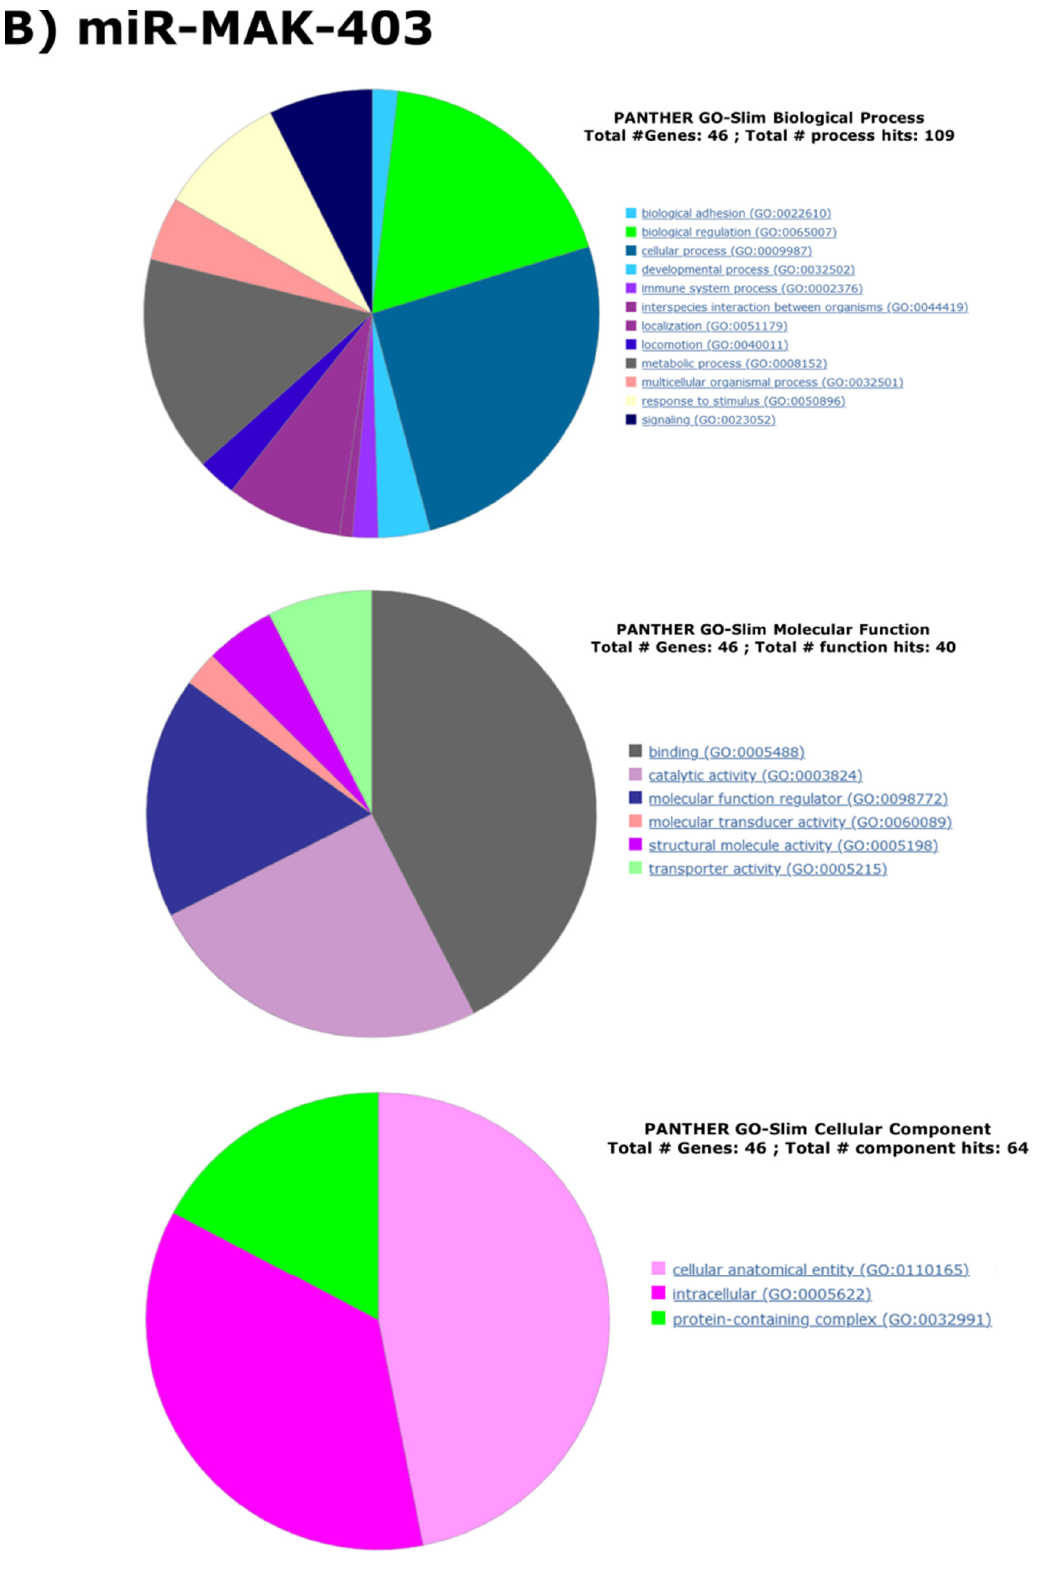
Figure 4. Pie charts of GO-Slim analysis based on EBOV miR-MAY-251 ( A ) and EBOV miR-MAK-403 ( B ) targets. EBOV miR-MAY-251 and EBOV miR-MAK-403 targets with scores >80% were subjected